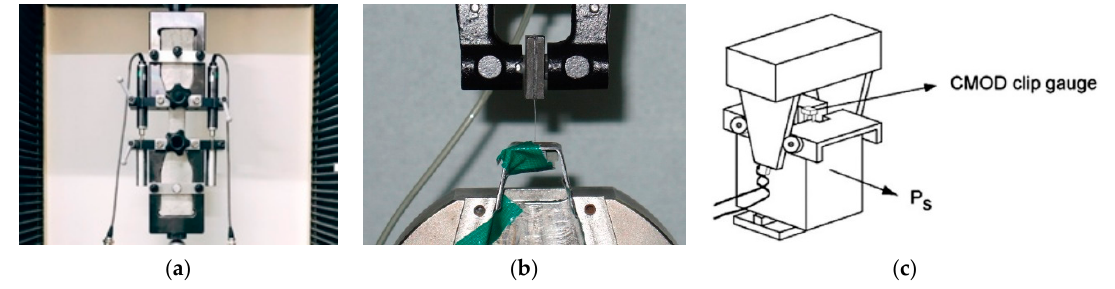
Figure 2. Experimental setup for ( a ) uniaxial tension test; ( b ) single fiber pullout test; and ( c ) matrix fracture test.